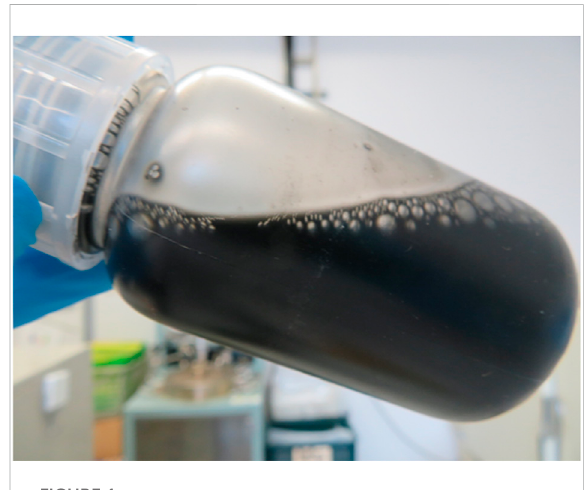
FIGURE 1 Photograph of typical graphite water dispersion obtained by sonication for SESC lignin water